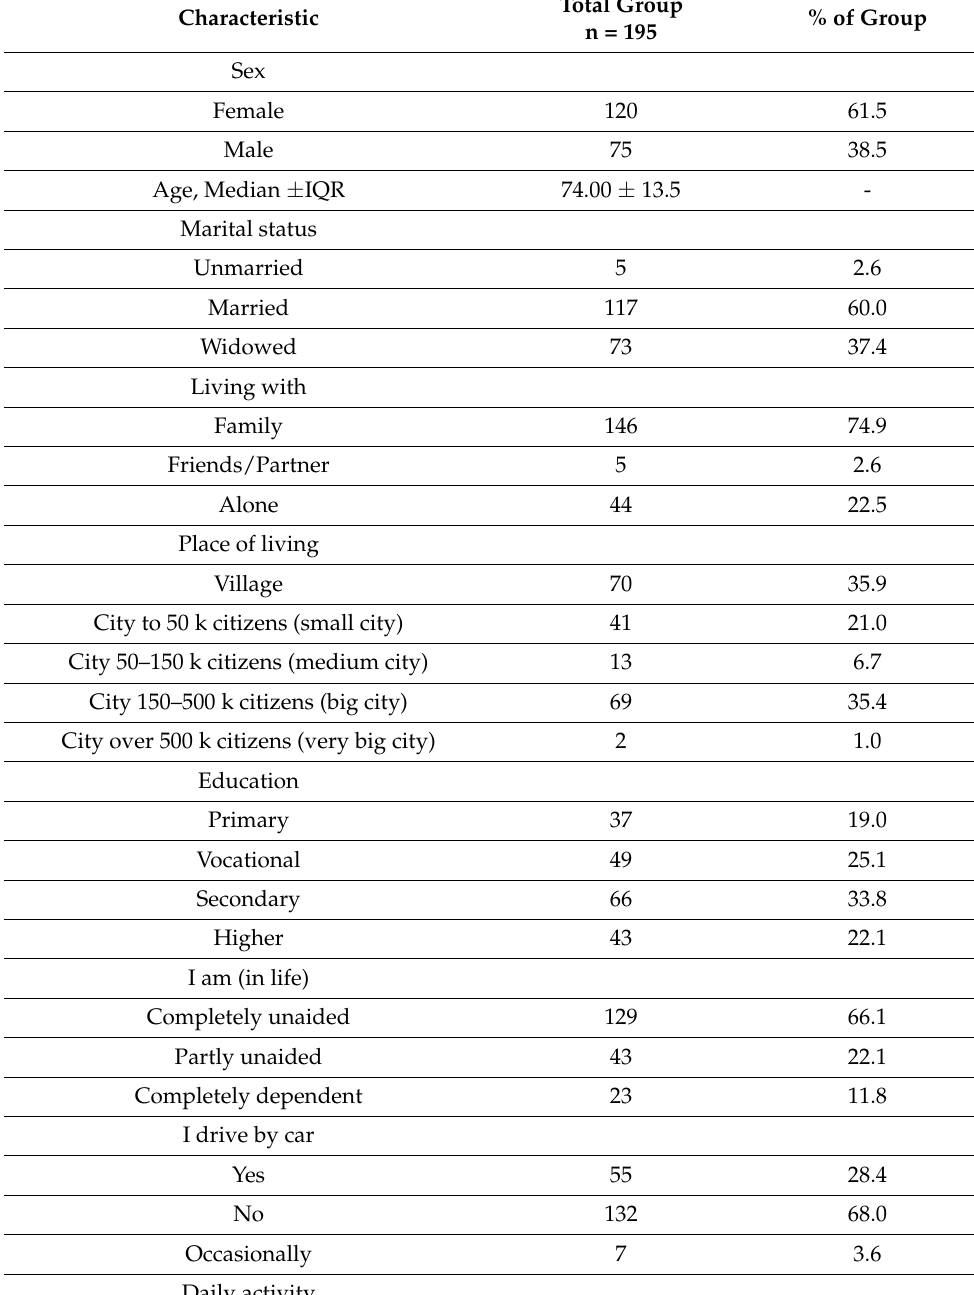
Table 1. Sociodemographic characteristics of the studied group of patients subjected to immediate sequential bilateral cataract